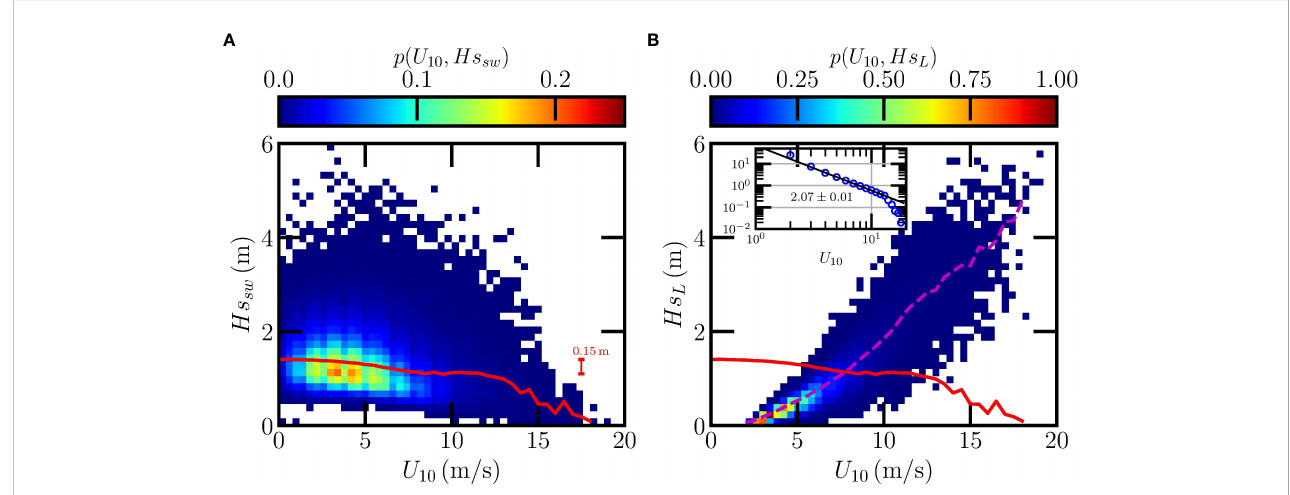
FIGURE 4 Measured joint PDFs of (A) U 10 and Hs sw , and (B) U 10 and Hs L extracted from the data provided by NDBC buoy 46086 with SEP analysis. The solid and dashed curves are the conditional average Hs sw and Hs L , respectively. The inset in (B) shows the ratio between (cid:1) Hs sw and (cid:1) Hs L at various wind speeds. The solid line indicates the best fi t with the slope of − 2.07. The maximum statistical difference between two subsets with equal sample size is indicated by an error bar in (A)